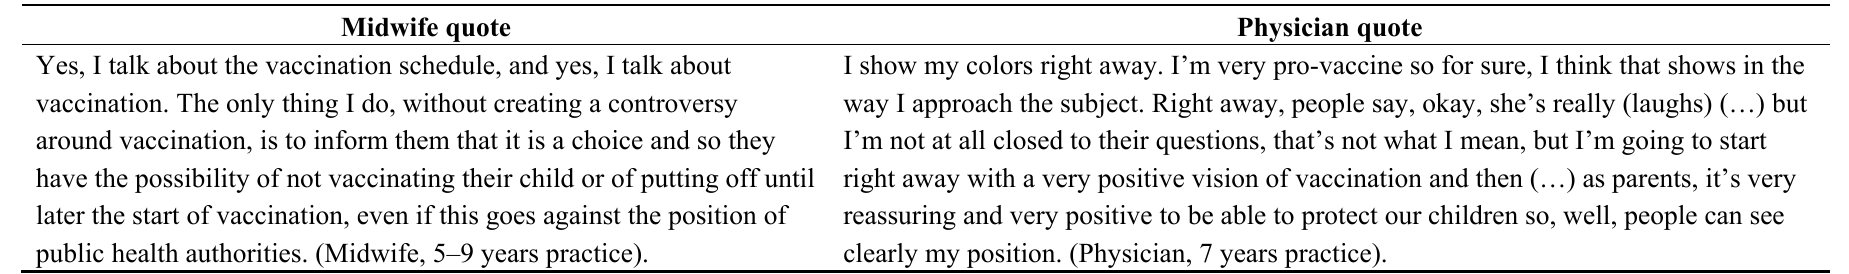
Table 3. Approaches of physicians and midwives regarding vaccination counseling.